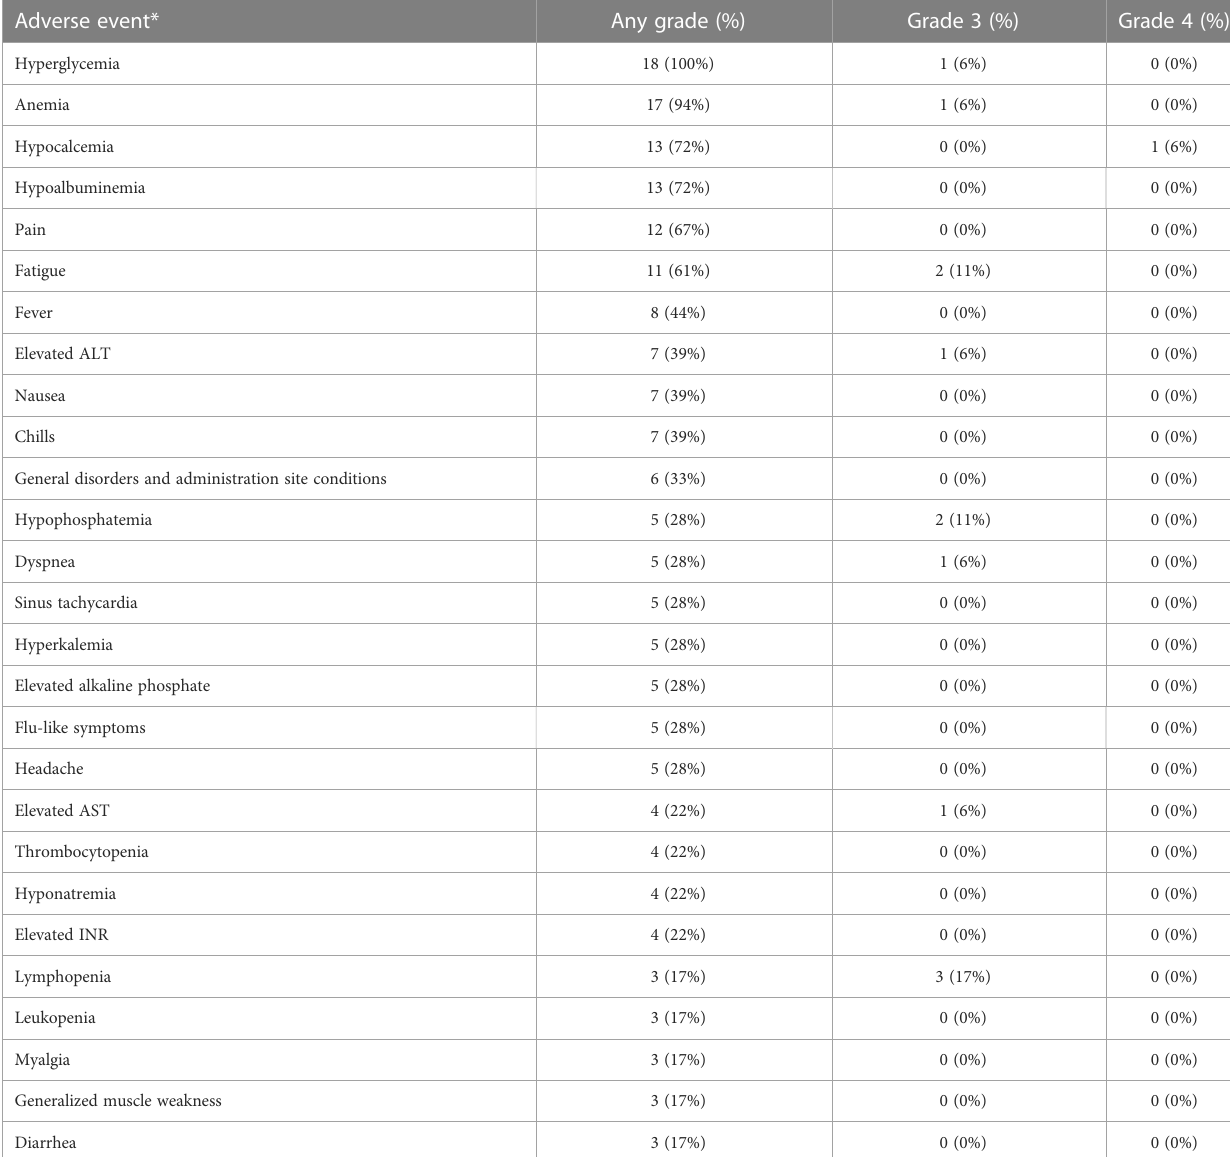
TABLE 2 Adverse events that occurred during the phase I trial